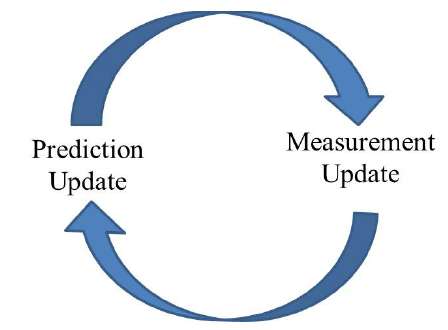
Figure 1. Generic Kalman filter propagation states